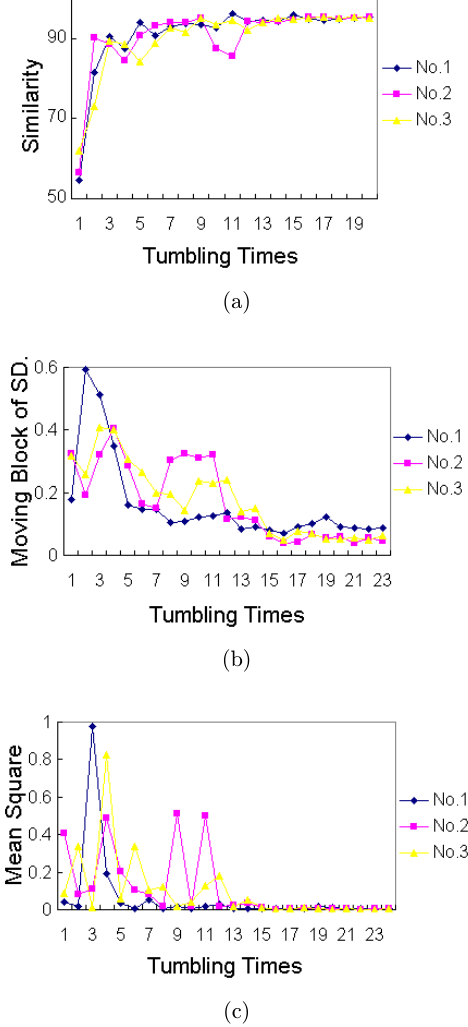
Fig. 6. Similarity (a), moving block values (b) and mean square (c) pro¯les of the simulated \liu wei di huang" blending as a function of tumbling